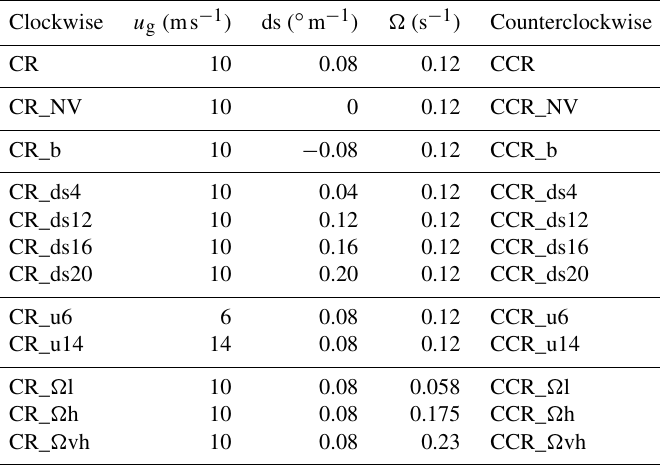
Table 1. List of all performed simulations in this study for a clockwise (leftmost column) and a counterclockwise (rightmost column) rotor rotation. The parameters u g , ds, and (cid:127) refer to both rotational directions, whereas the only difference e.g., between CR and CCR in the first line is the rotational direction. Further, _NV represents no wind veer and _b a backing wind, _ds refers to varying the directional shear, _u refers to varying the geostrophic wind, and _ (cid:127) refers to varying the rotational frequency in the corresponding simulations. Simulations with different rotational directions of the rotor Clockwise u g (ms − 1 ) Counterclockwise